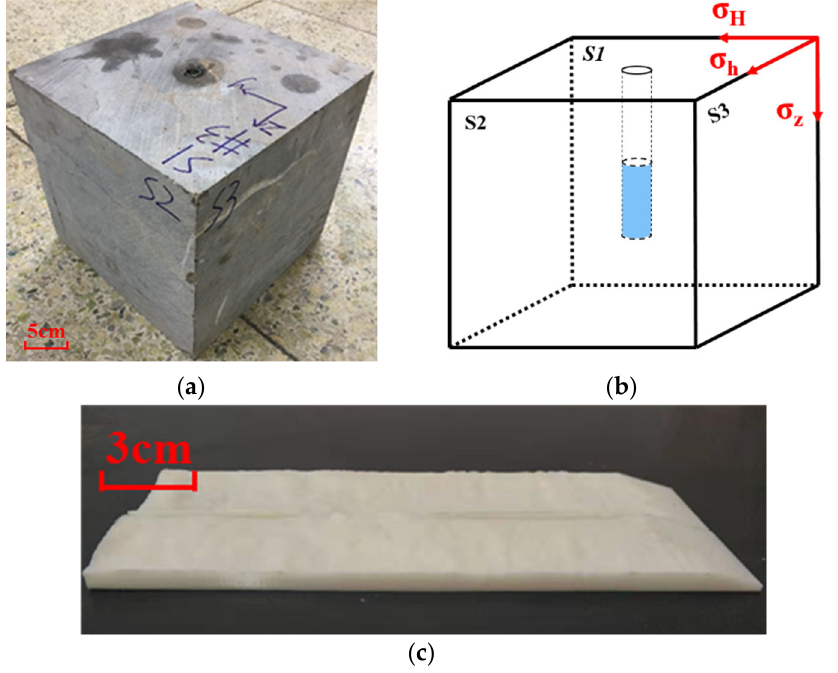
Figure 2. Experimental specimen ( a ) Physical diagram of specimen for triaxial fracturing test; ( b ) Schematic diagram of specimen for triaxial fracturing test; ( c ) 3D printing rock plate. The above rock blocks can also be reused after fracturing. Select appropriate